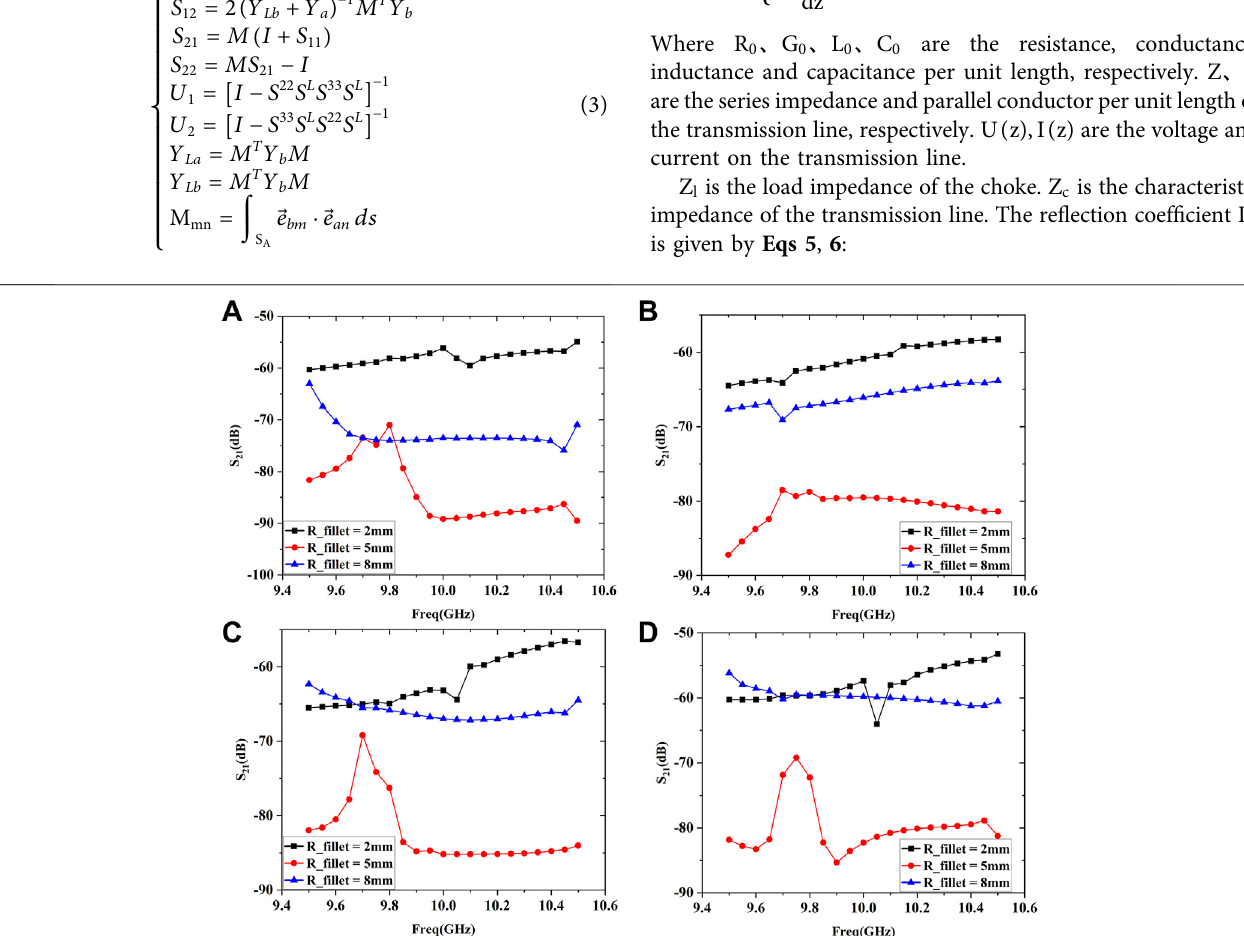
Frontiers in Physics |